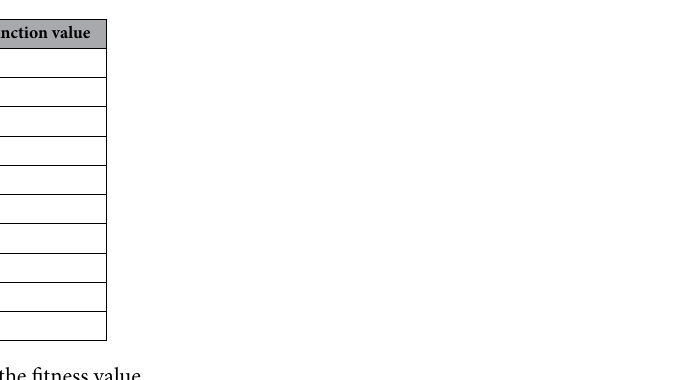
Table 1. Effect of weights on the fitness